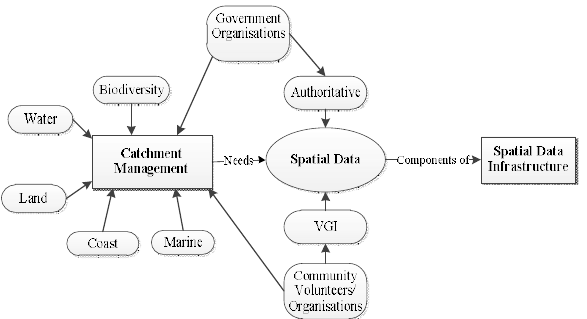
Figure 1. Conceptual framework